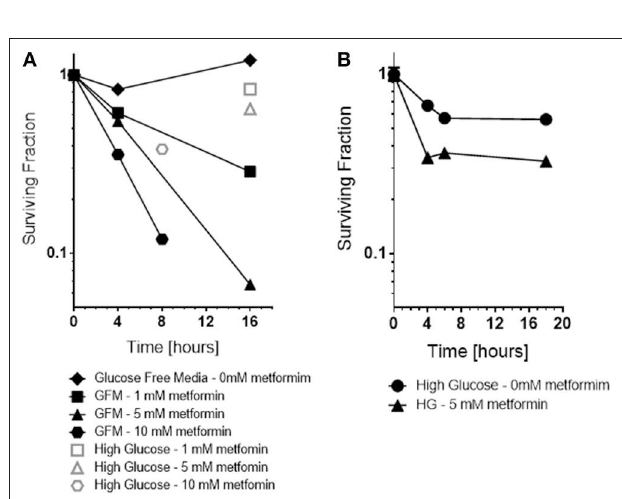
FIGURE 5 | In vitro , the cytotoxicity and radiation sensitization of metformin were examined under various microenvironment conditions including glucose concentration (A) , pH (not shown because effect size was small) and hypoxia (B) . Glucose concentration had the greatest effect; glucose free media increased metformin cytotoxicity and radiation sensitization. For comparison, cell surviving fraction is shown (Open symbols) for cells exposed to 5mM metformin under “high glucose”